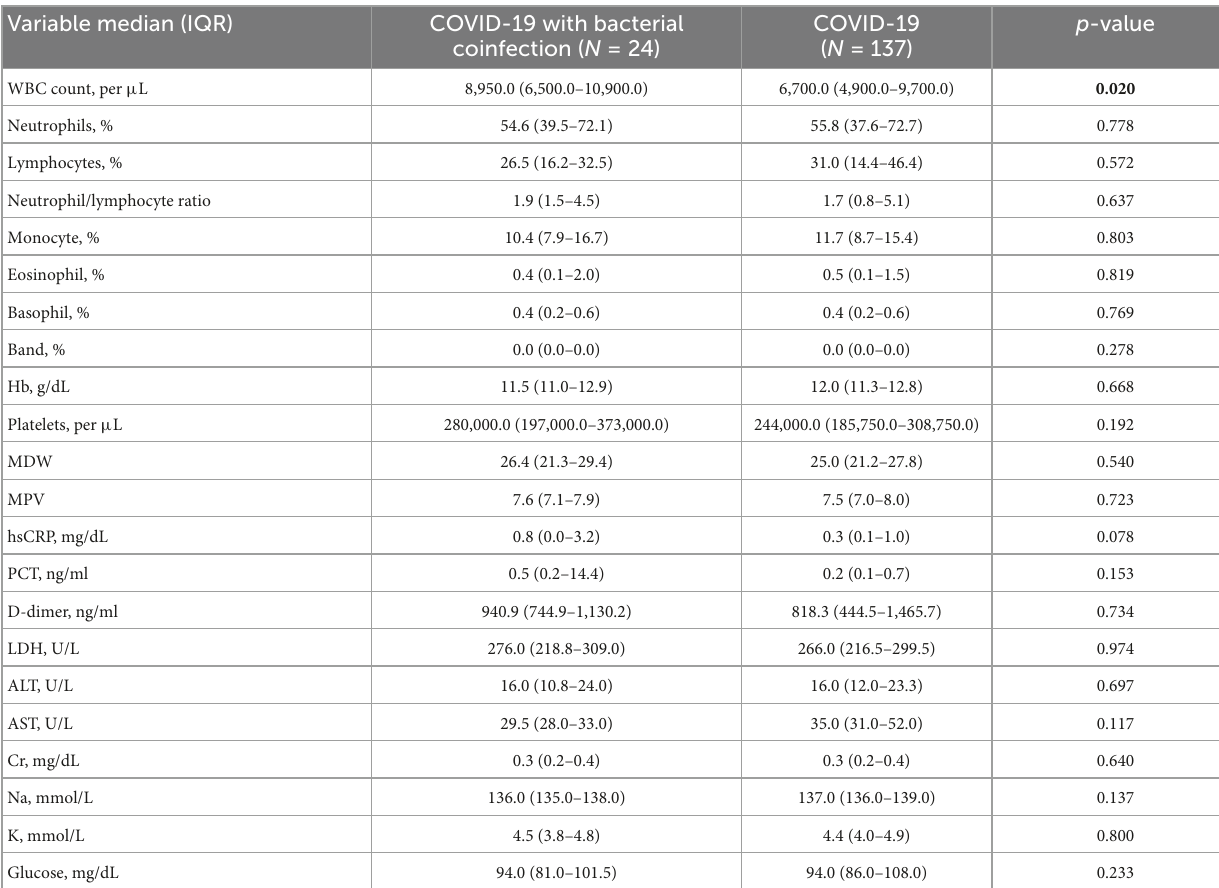
TABLE 2 Comparison of laboratory parameters of both groups.